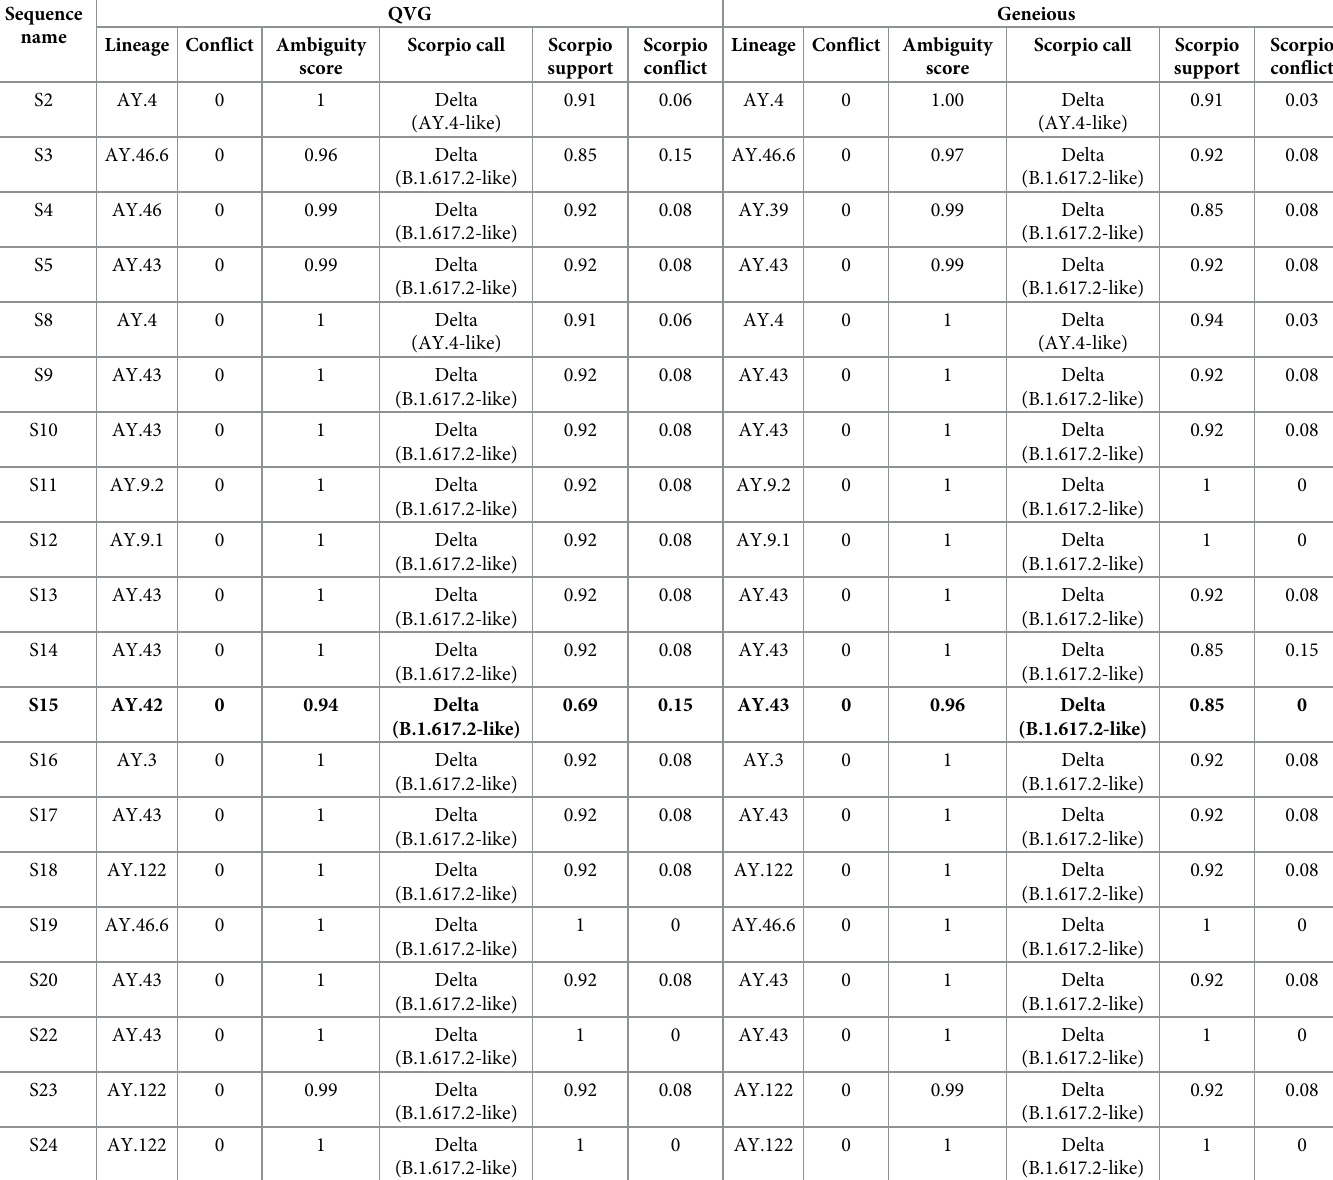
Table 2. Comparison of pipelines used in this study by the lineage assignment and support values as output by Pangolin. The only sample assigned differently after genotyping by the two compared pipelines is given in bold. Sequence